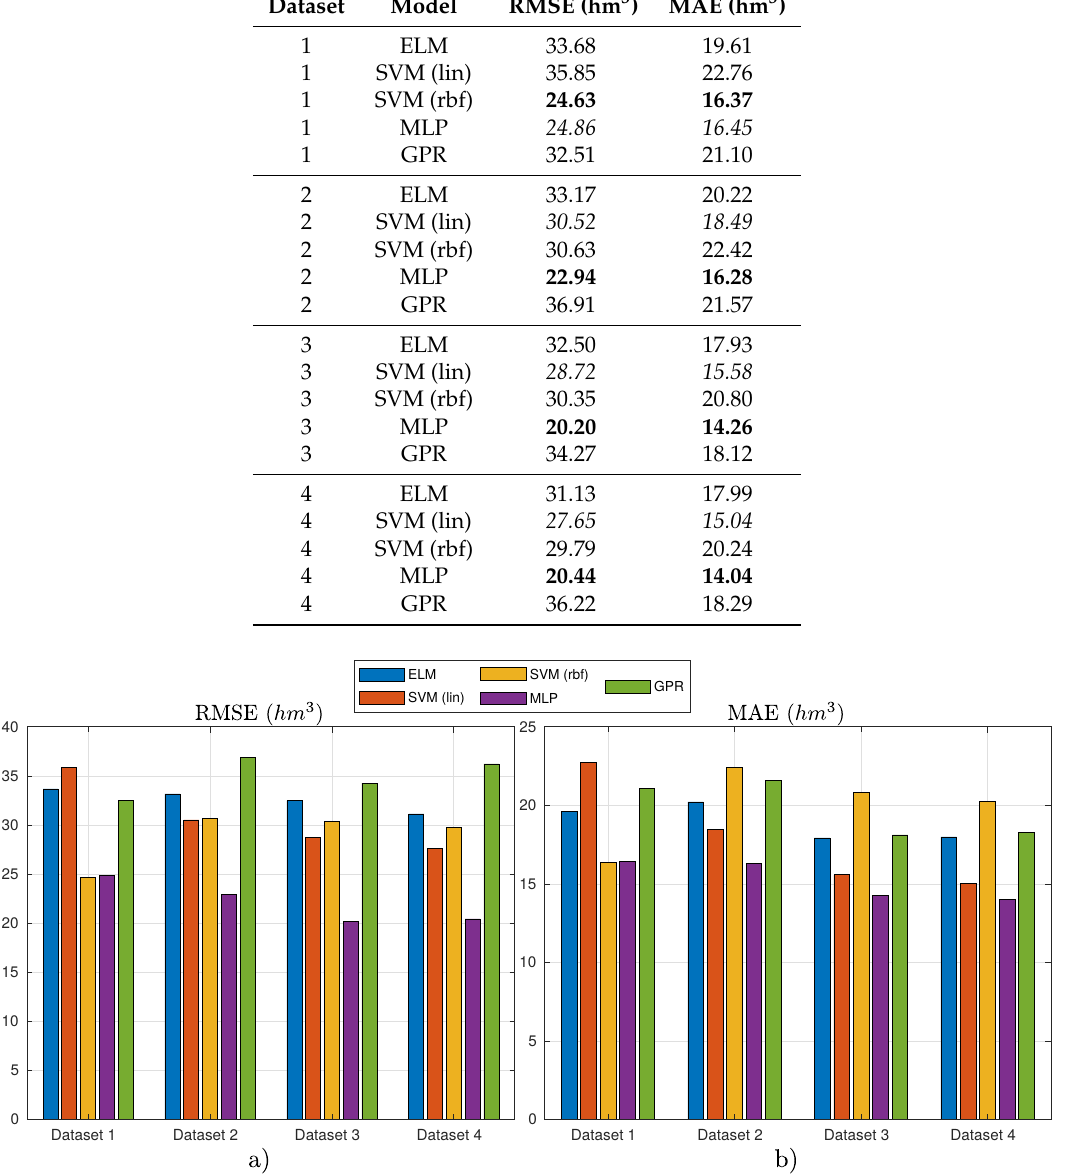
Table 4. Results of the different ML regression techniques for different variables considered (datasets) in the case of standard data (all seasons) and random partitioning. Boldface stands for the best value found in a dataset, and italic for the second best.